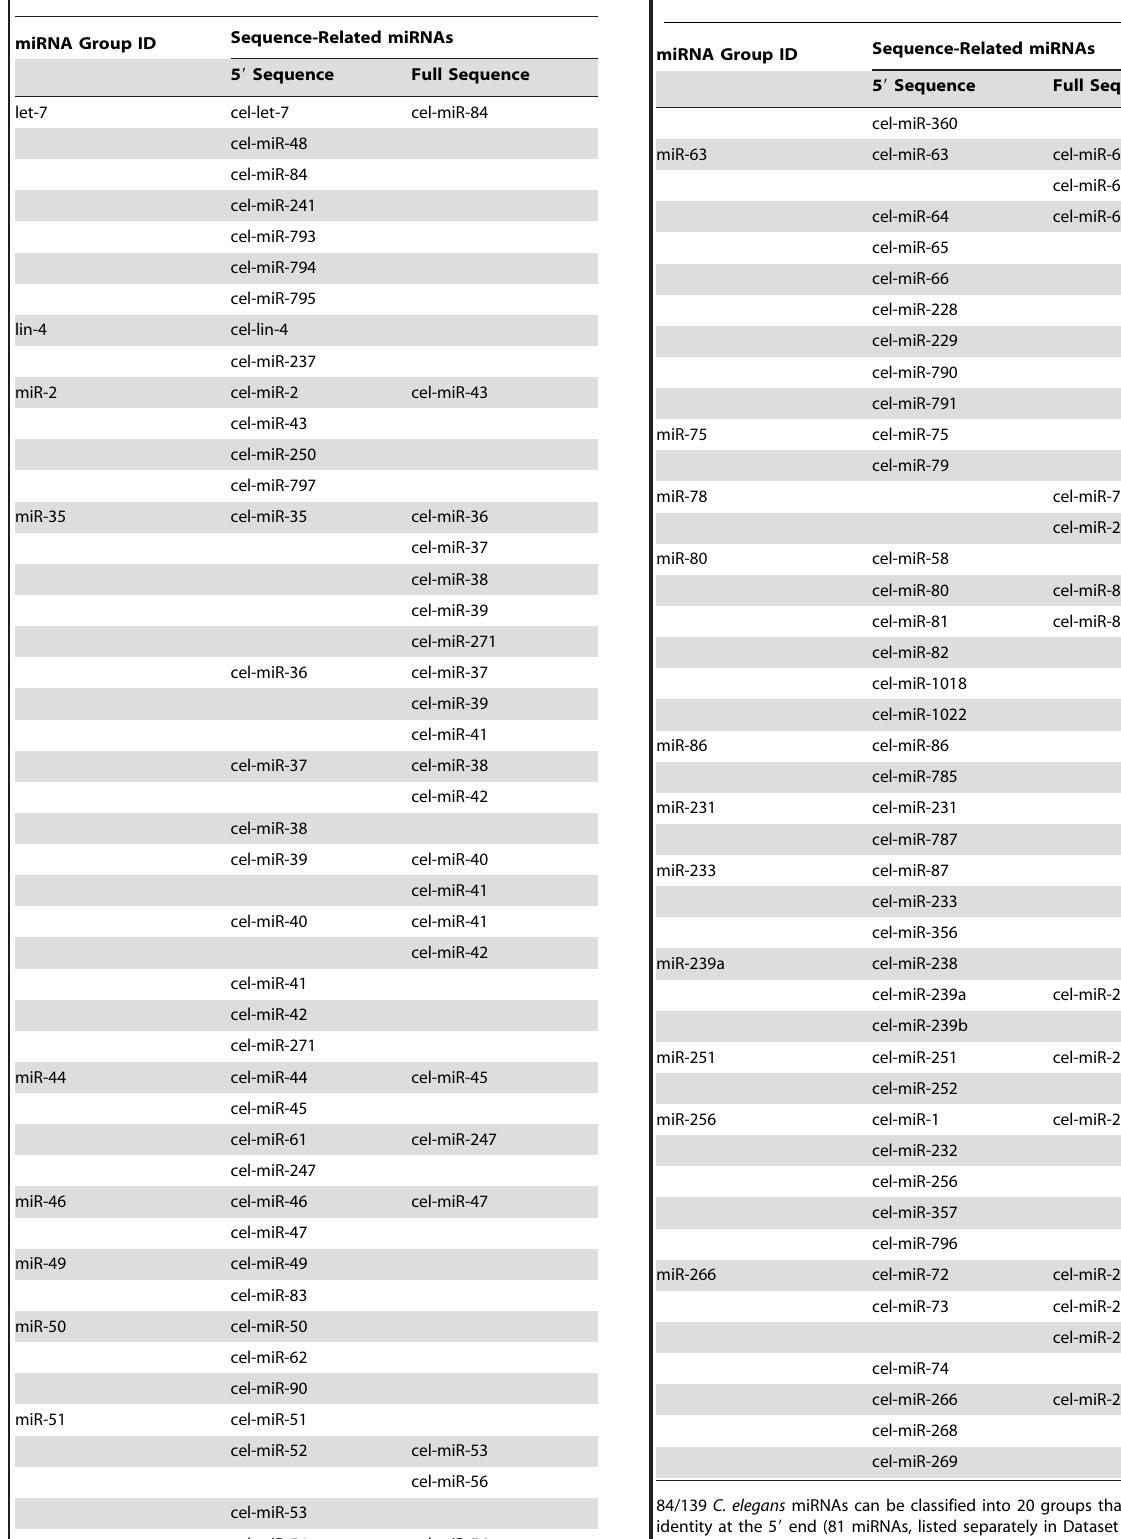
Table 1. Summary of C. elegans miRNA relationships. Table 1.